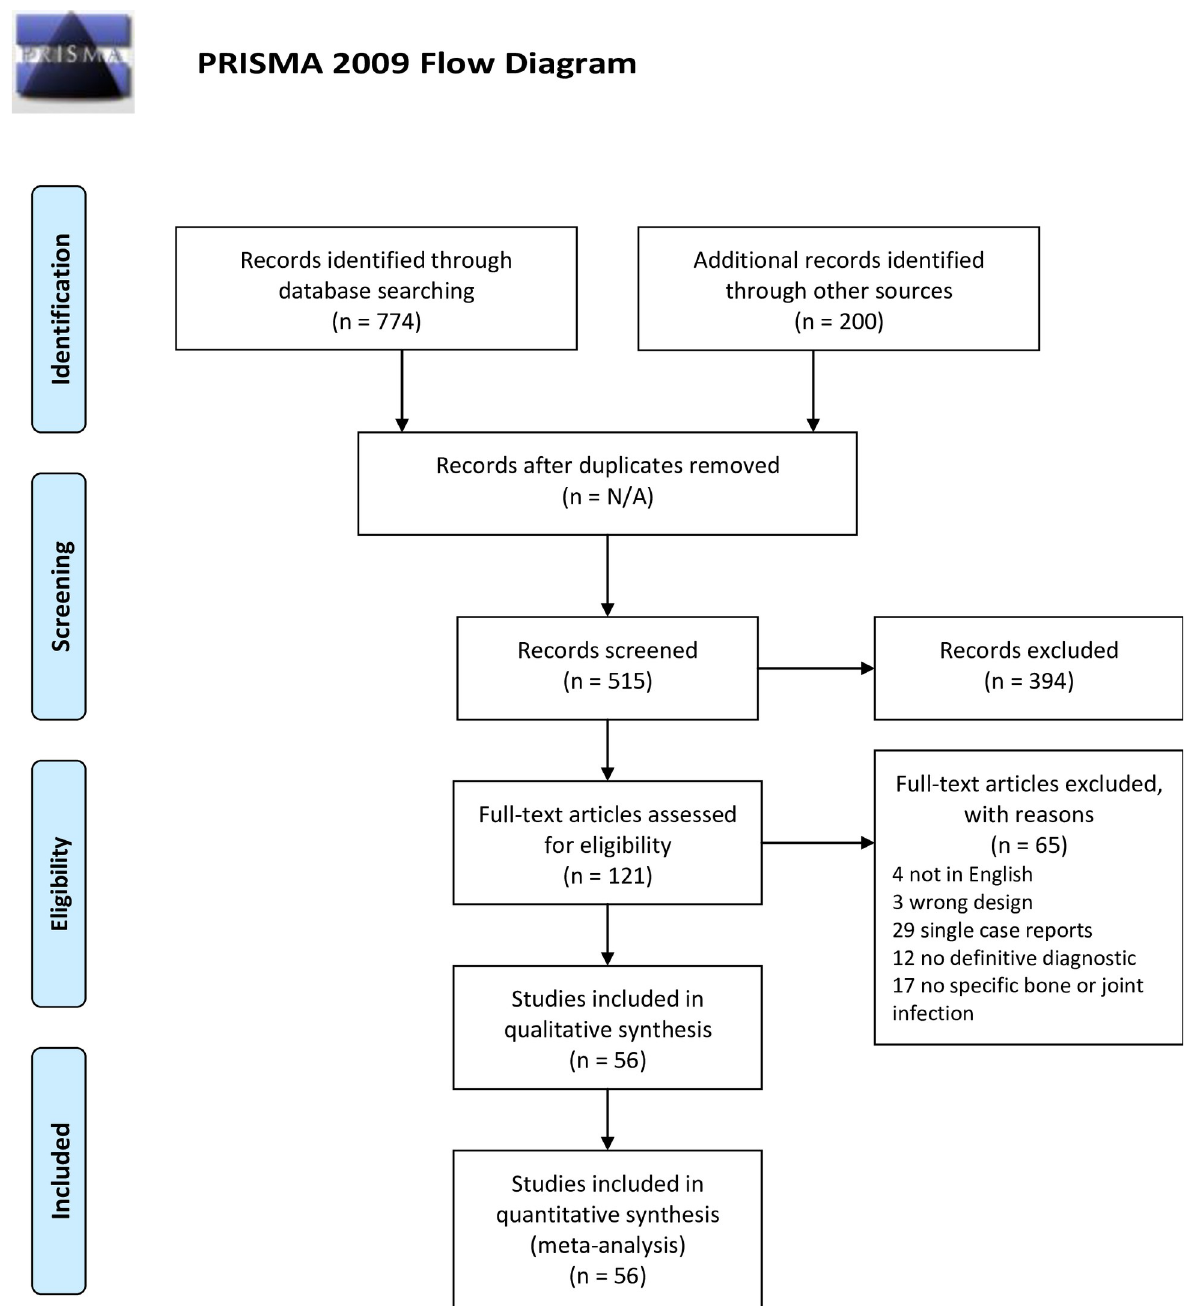
Fig 1. Flow-chart of systematic review of osteoarticular